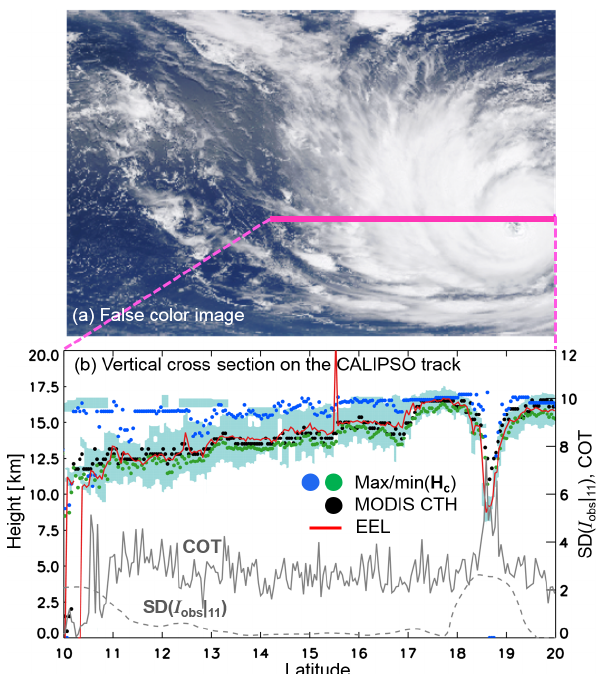
Figure 6. (a) MODIS false color image (rotated 90 ◦ left) at 03:20UTC on 19 August 2015. This scene captures part of Typhoon Goni. The heavy pink line on the image shows the CALIPSO track the closest to MODIS observation time. (b) Vertical cross section of the CALIPSO track designated by the heavy pink line in Fig. 6a. The vertical feature mask is shown as sky-blue contours (randomly and horizontally oriented ice). The red solid line shows where the layer COT (integrated Q e at 532nm from CALIOP) reaches a value of 0.5. The green–blue and black circles are the min–max( H c ) and MODIS CTH, respectively. The gray solid (dashed) line on the right-side y axis is the column COT from CALIOP (standard de- viation of 11µm radiances from MODIS).